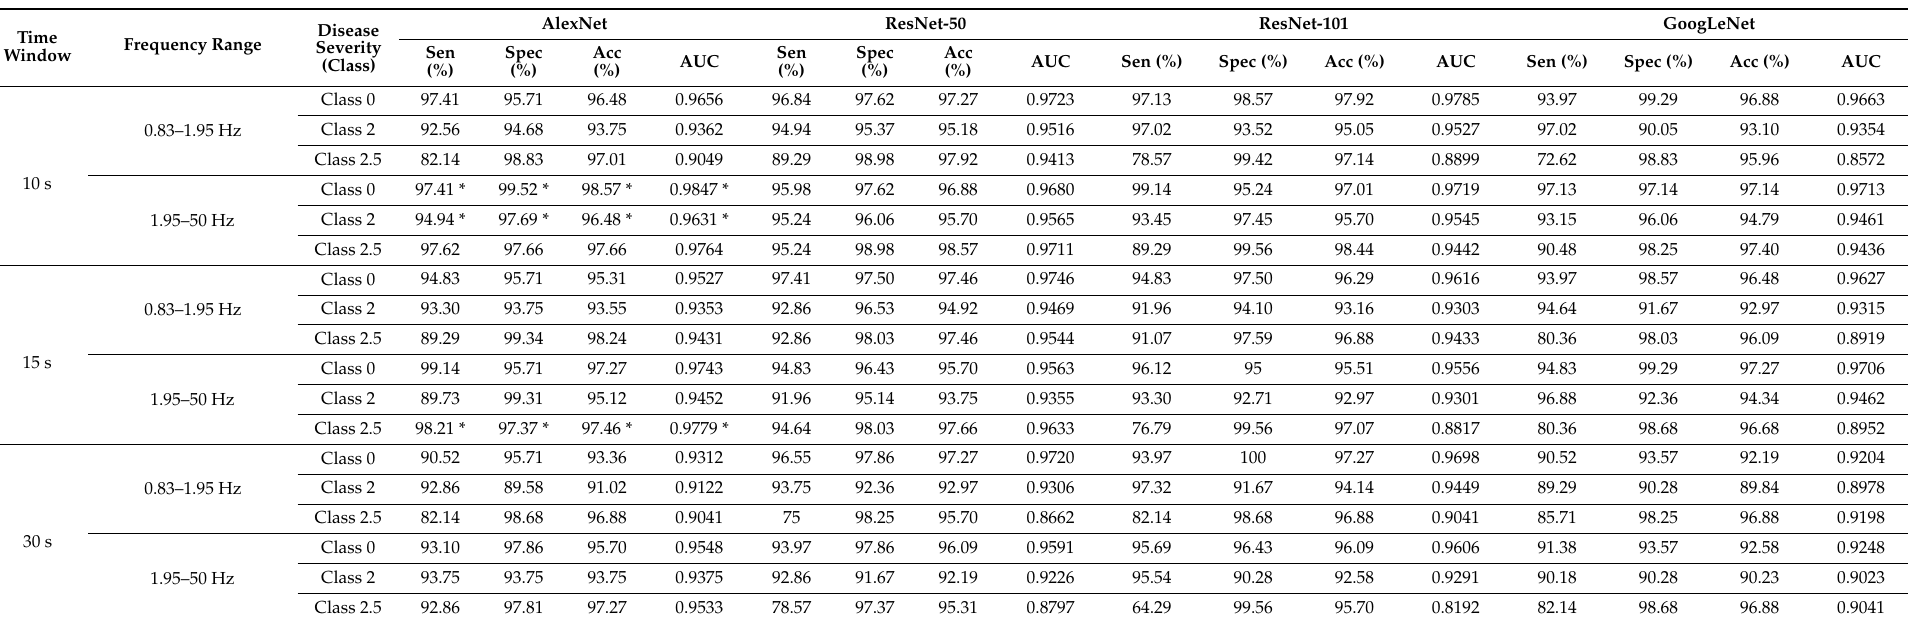
Table 13. Multi-class classification of CF from Si dataset for CO (Class 0), PD Stage 2 (Class 2), PD Stage 2.5 (Class 2.5), and PD Stage 3 (Class 3) using several CNN classifiers (AlexNet, ResNet-50, ResNet-101, and GoogLeNet) with 10-fold